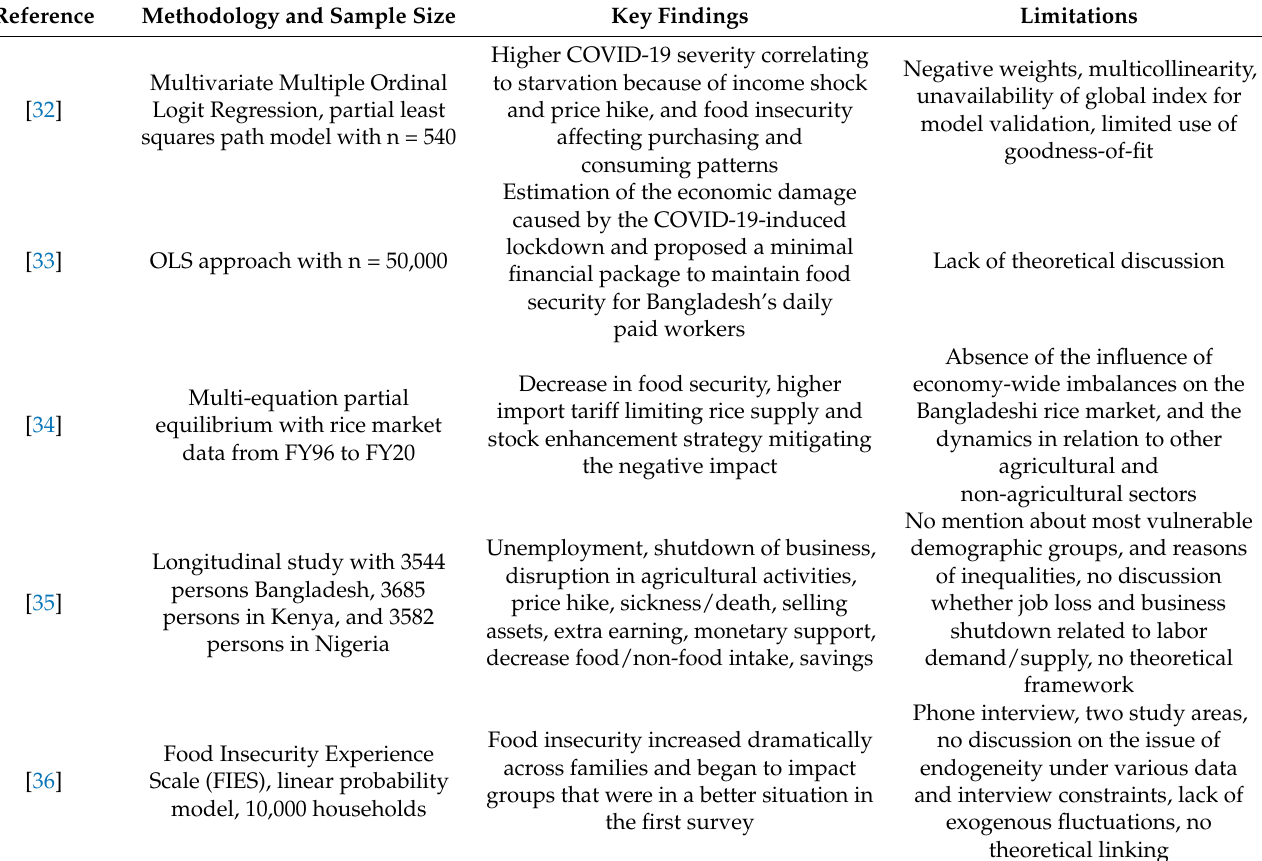
Table 1. Tabular literature review of COVID-19 researches on food security in